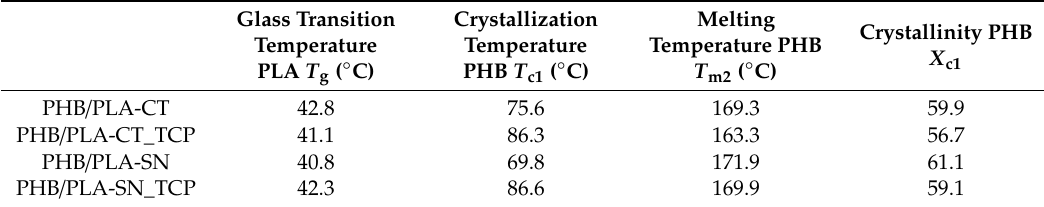
Figure 1. First cooling and second heating DSC scans of prepared materials. Table 3. Thermal properties of tested materials.